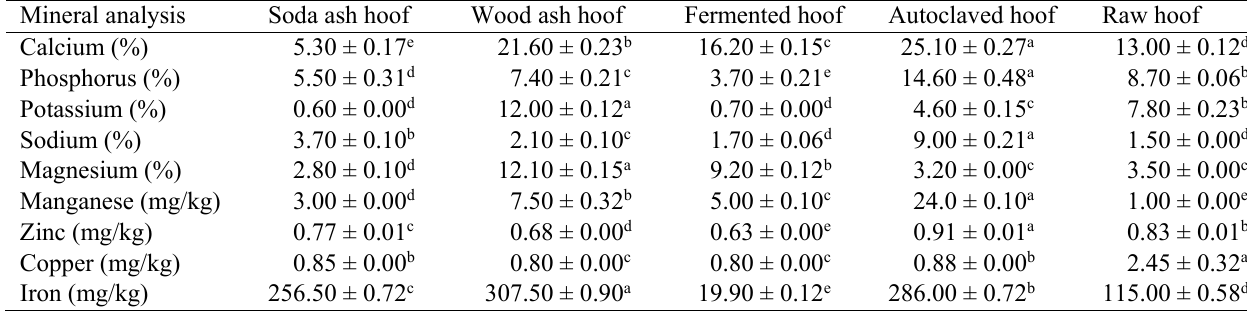
Mineral profile of differently processed Cattle Hoof Mineral